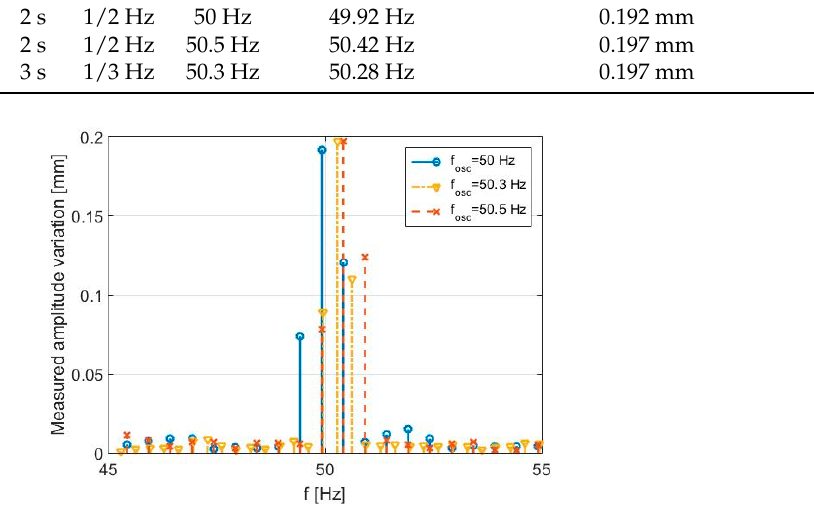
Figure 13. Parameters and results of the first experimental validation test (second test).